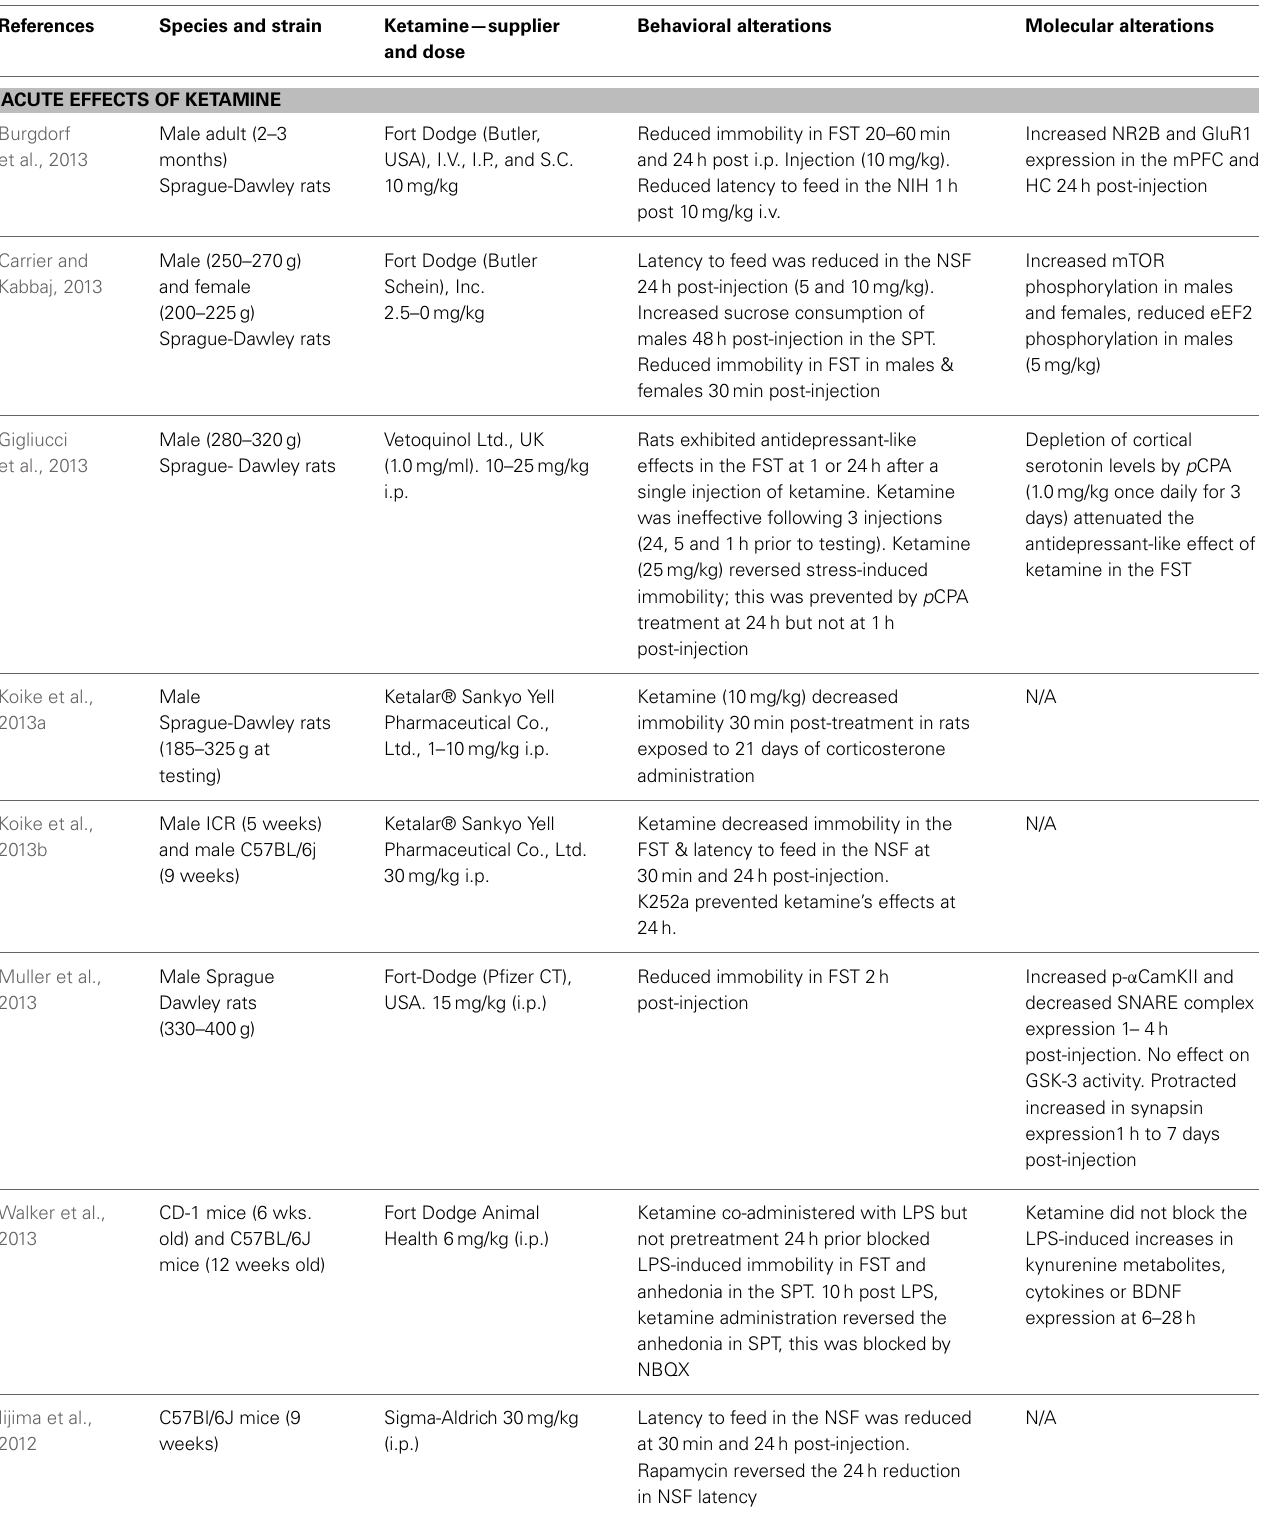
Table 1 | Acute effects of